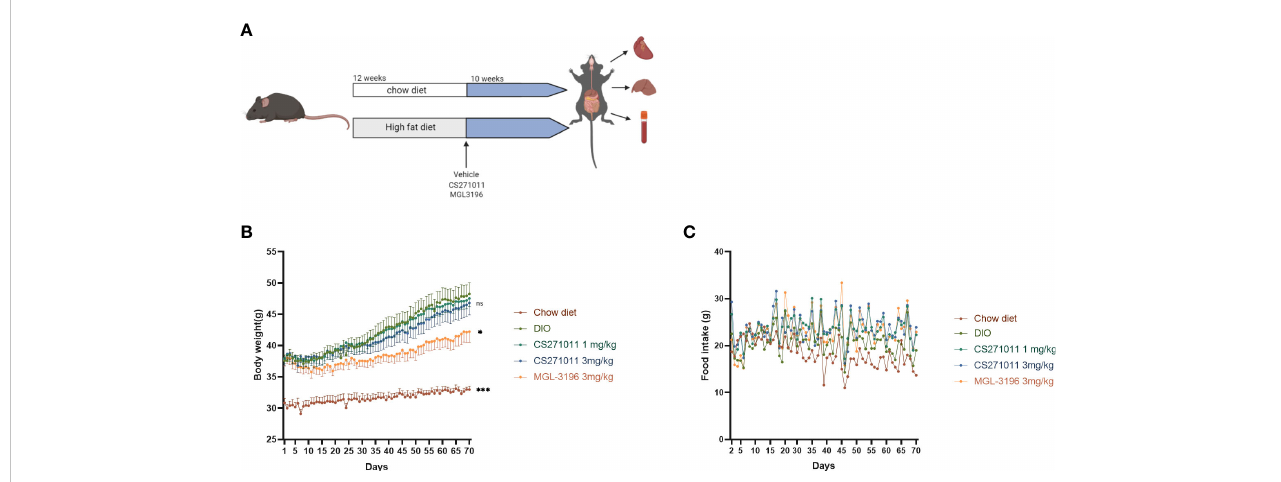
FIGURE 2 Effects of CS271011 and MGL-3196 on body weight and food intake in the DIO model. (A) CS271011 treatment strategy design; (B) Body weight change of mice during the 10-week treatment with CS271011; (C) Change in food intake. The results are presented as the mean ± SD. *p < 0.05 and ***p < 0.001 represent data vs. DIO controls; ns, not signi fi cant;